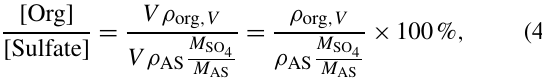
K n (d) = 2 λ g /d is the Knudsen number, and λ g is the gas mean free path. In this work, d a was given by the AAC; χ was determined by d m and d va (Appendix